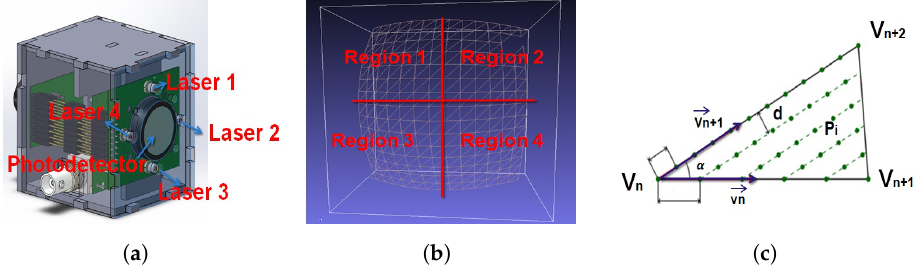
Figure 8. Three-dimensional (3D) final mesh generation using CW-iTOF reference: ( a ) laser array and InGaAs photodetector, ( b ) defining reference regions, and ( c ) method of distribution of points of the mesh (d distance (pitch), v n , v n + 1 and v n + 2 vertices, P i points